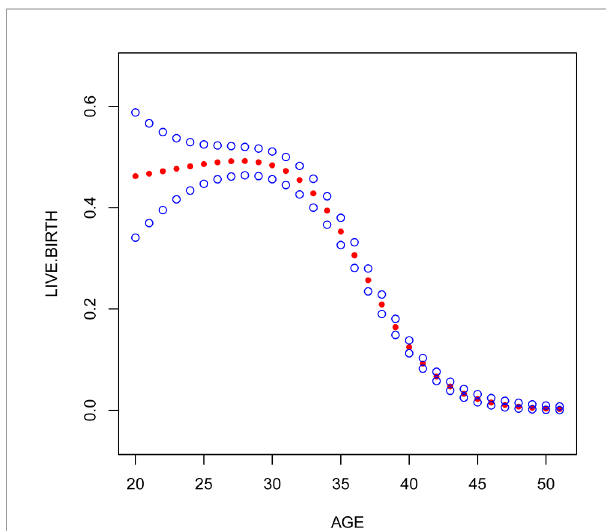
FIGURE 2 | Association between live birth and BMI. A threshold, nonlinear association between live birth and these independent predictive factors was found in a generalized additive model (GAM). Solid rad line represents the smooth curve fi t between variables. Blue bands represent the 95% of con fi dence interval from the fi